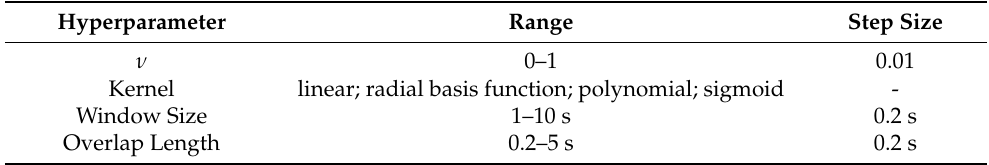
Table 1. Hyperparameter tuning parameter